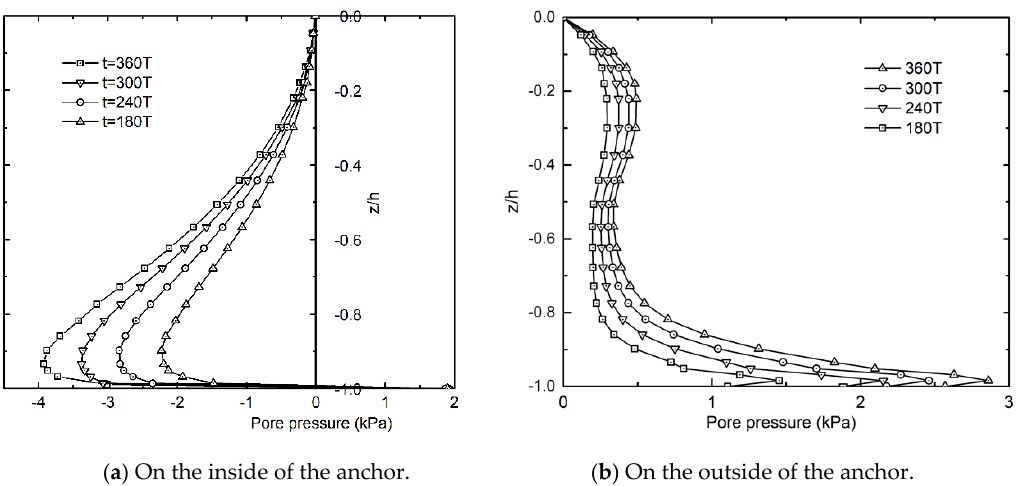
( a ) On the inside of the anchor. ( b ) On the outside of the anchor. Figure 10. Vertical distribution of the residual pore pressures in the soil along the anchor wall.